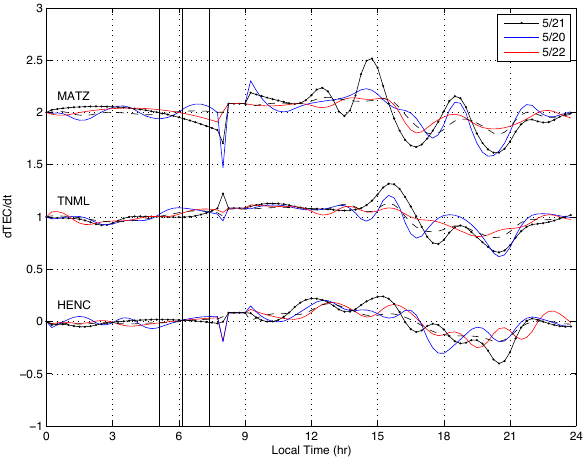
Fig. 8. The TEC rate at three GPS stations (a) MATZ, (b) TNML, and (c) HENC during the solar eclipse on 20 (blue lines), 21 (dotted lines), and 22 (red lines) May 2012, and the monthly mean (dashed